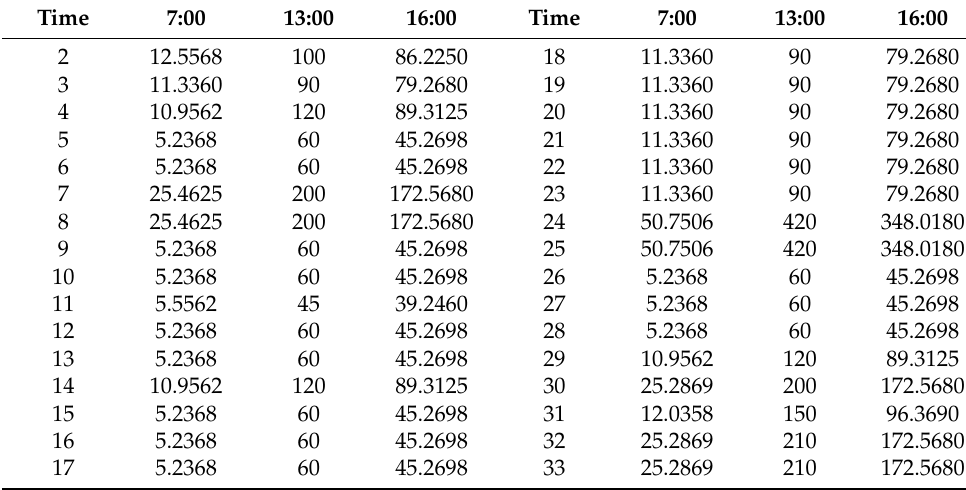
Table A1. Load power of each node at different times (kW).